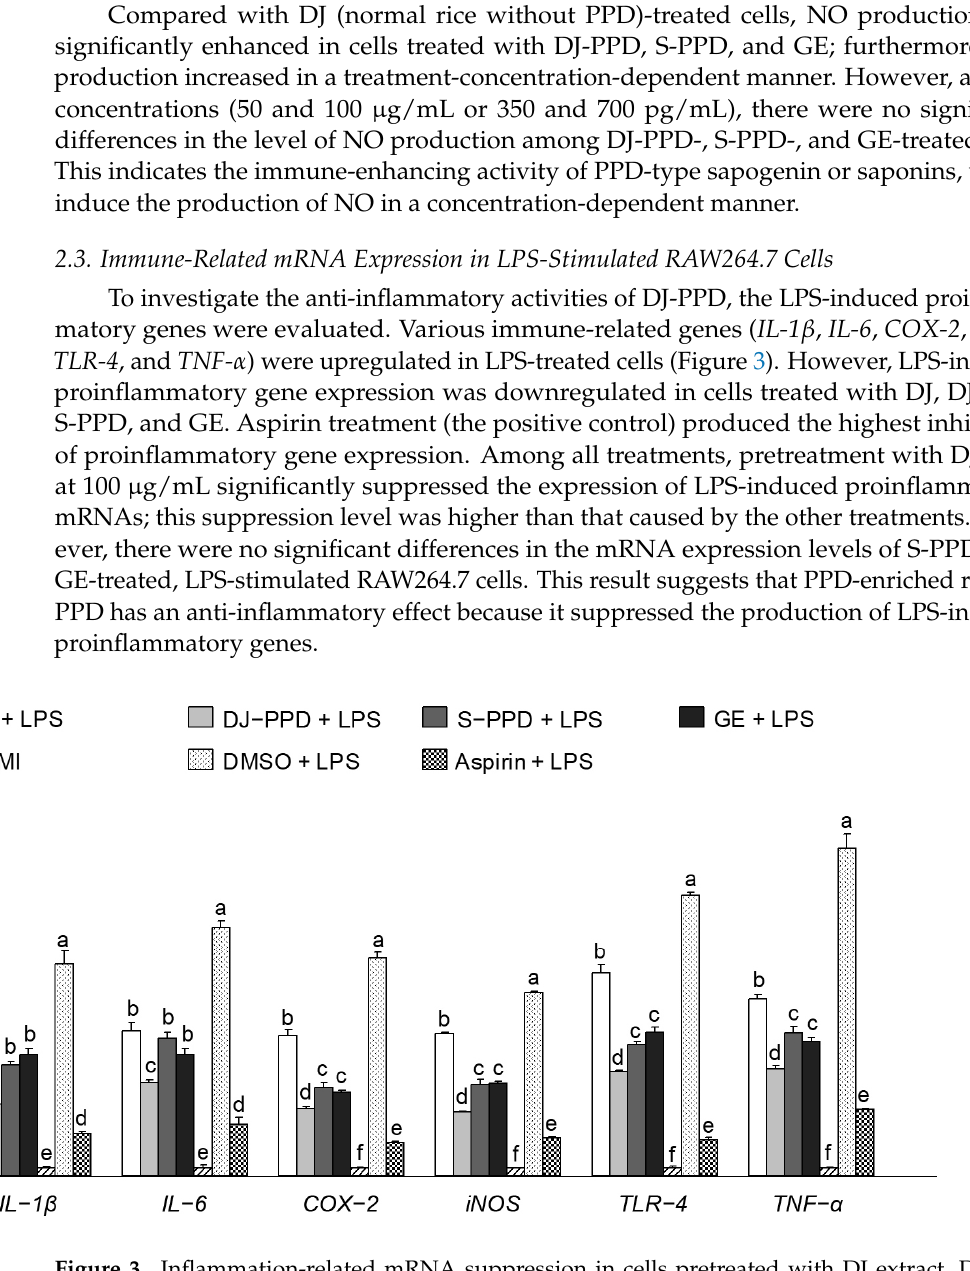
Figure 3. Inflammation-related mRNA suppression in cells pretreated with DJ extract, DJ-PPD extract, S-PPD, and GE extract, together with LPS stimulation. After 6 h of LPS stimulation, cells were collected for RNA extraction. DJ, DJ-PPD, and GE concentrations were 100 µ g/mL, whereas that of S-PPD was 700 pg/mL. DMSO and aspirin concentrations were 0.1% and 200 µ g/mL, respectively. Data are shown as means ± standard deviations. Different lowercase letters indicate significant differences among treatments at p < 0.05.